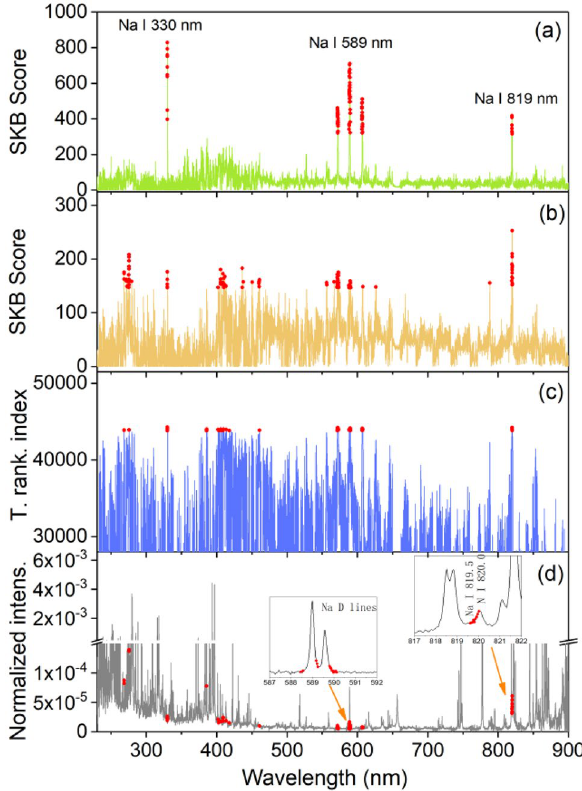
Figure 4. Results of feature selection for Na 2 O: ( a ) for pellets and ( b ) for training raw rocks, SKB scores of all the spectral channels, and the 100 selected features in red dots; ( c ) total ranking index of all the spectral channels and those of the 100 common selected features in red dots; ( d ) a typical normalized average spectrum from sample S1 in pellet form, together with the 100 common selected features in red dots, with 2 insets showing enlarged parts of the spectrum around 589 nm and 820